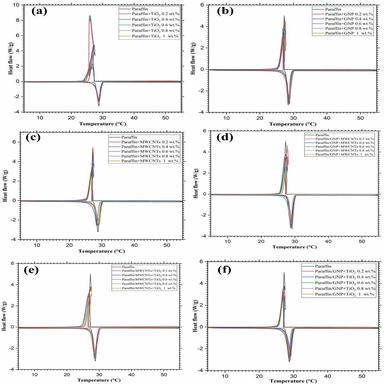
A comparison of DSC results from single and hybrid nano enhanced PCMs (a) PAR + TiO2, (b) PAR + GNP, (c) PAR + MWCNTs, (d) PAR/MWCNTs + GNP, (e) PAR/ MWCNTs + TiO2, and (f) PAR/GNP + TiO2.